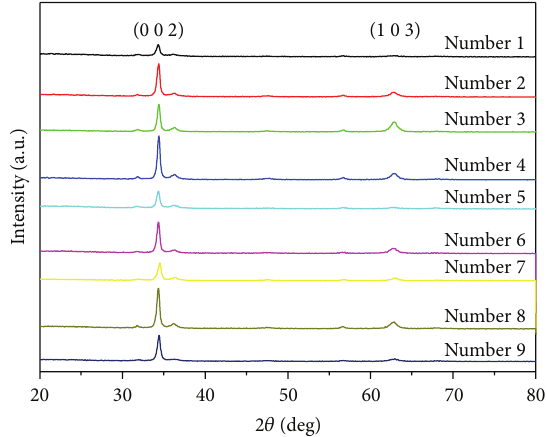
Figure 1: The XRD patterns of the of the ZnO films on glass substrates for the L9 orthogonal array from experiments number 1 ∼ 9.